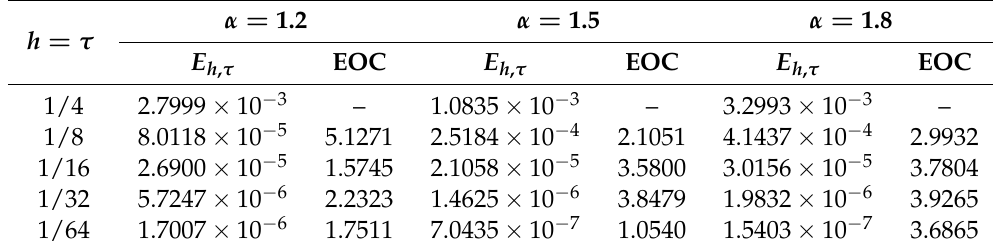
Table 2. The errors and EOCs of SAV-WSLD-Gauss2 method for Example 2 with different α and γ = 0 at time T = 1 by keeping h = τ